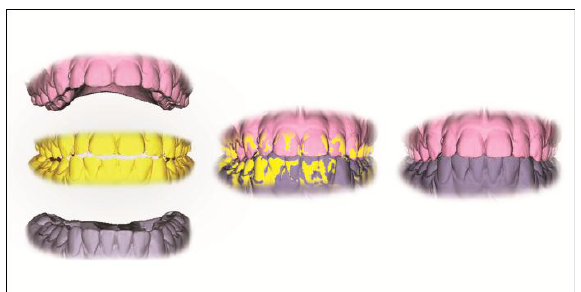
Figure 4. Stages of scanning and positioning for 3D models of opposing dental arches